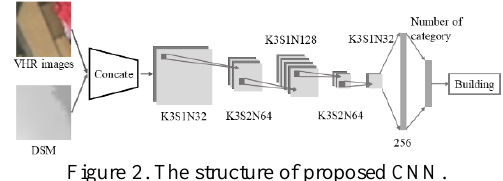
Figure 2. The structure of proposed